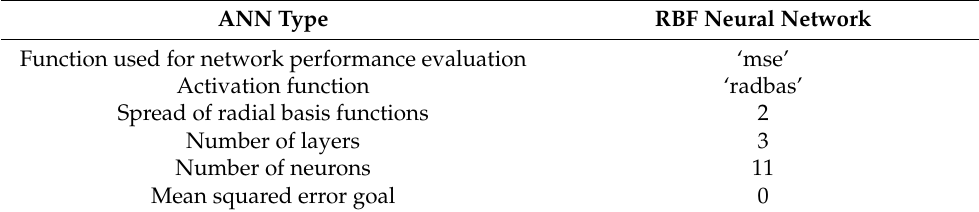
Table 1. Configuration of the proposed